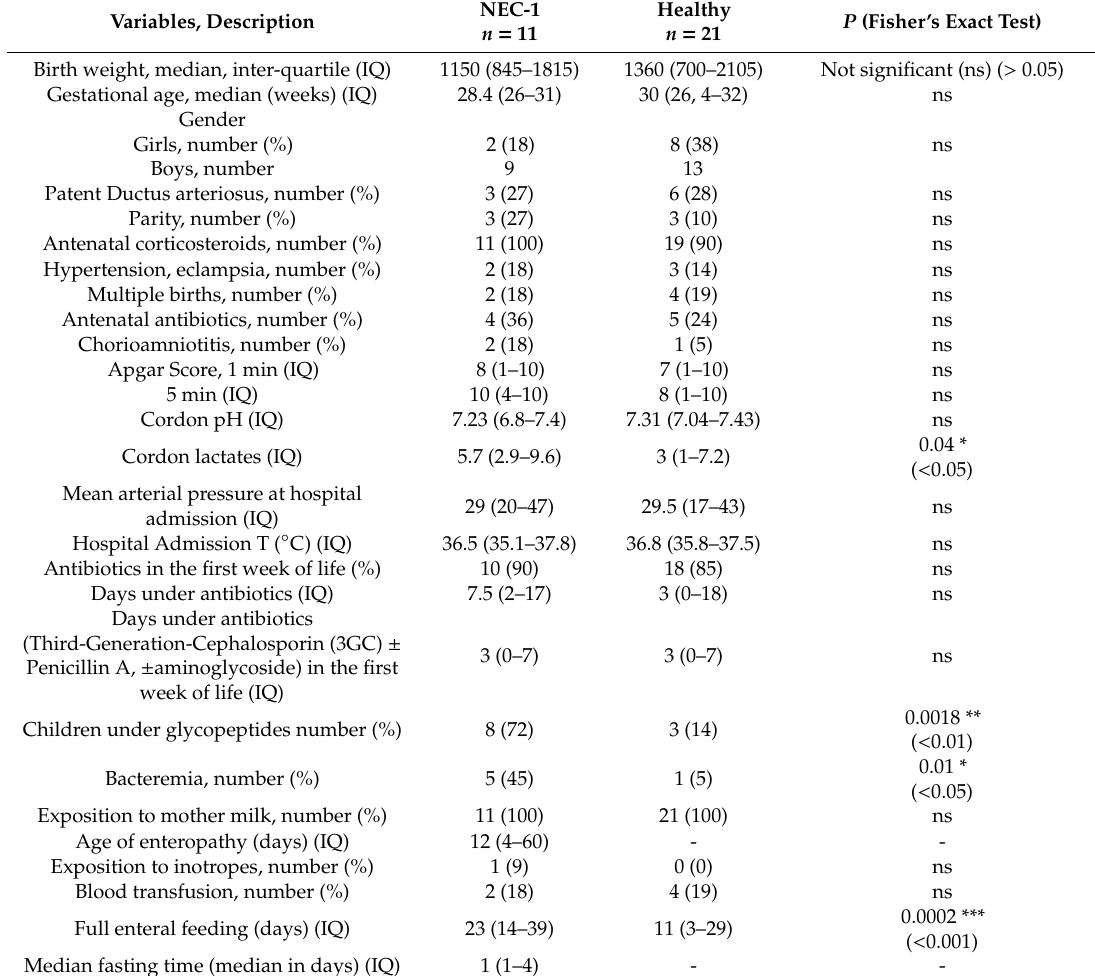
Table 1. Cohorts